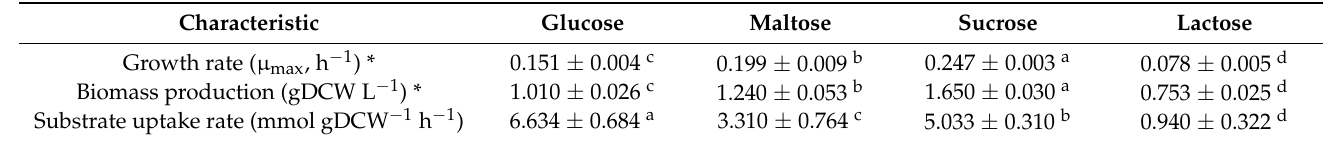
Table 2. Growth kinetic characteristics of L. reuteri KUB-AC5 using different carbon sources.